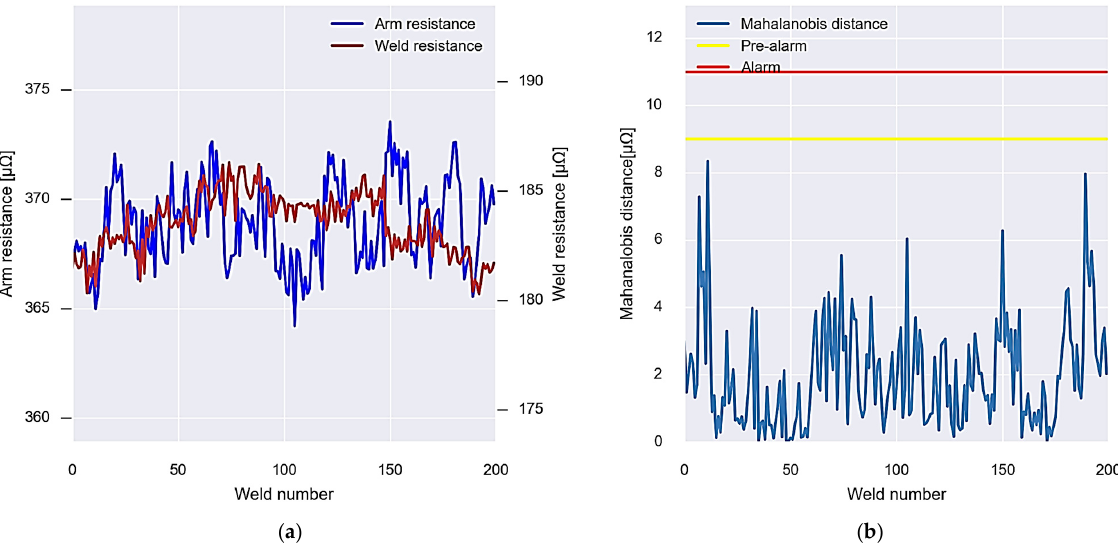
Figure 17. Operation of the first calibration algorithm for gun 3. ( a ) Data of the resistances used for the calibration. ( b ) Calibration result, Mahalanobis distance, and alarm thresholds.